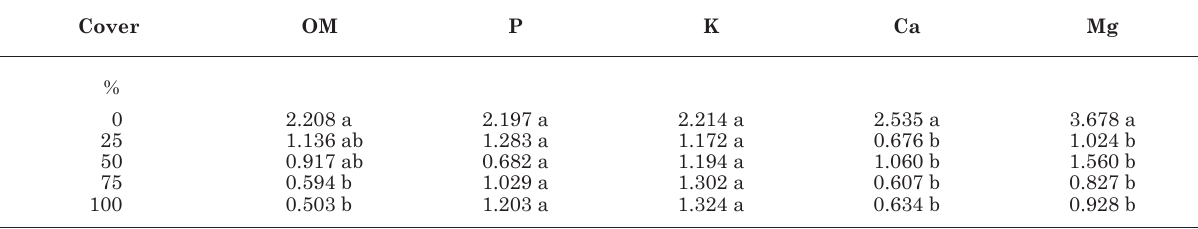
table 2. enrichment rate of sediment (er) by organic matter (om) and nutrients